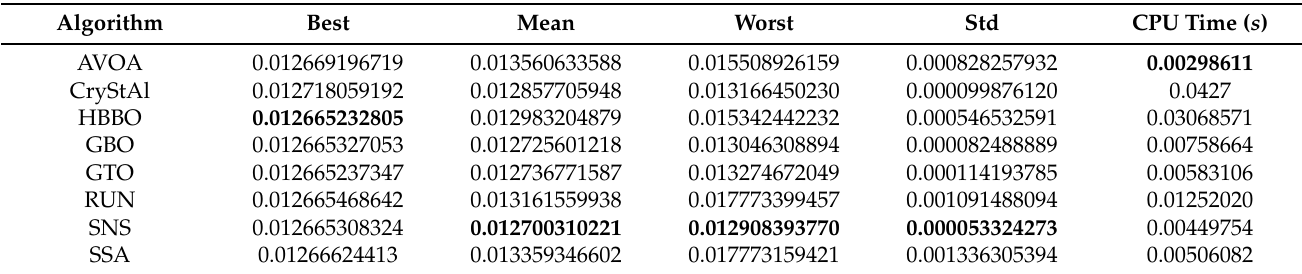
Table 4. Statistical findings of the bench-marked algorithms for the tension/compression spring design problem.